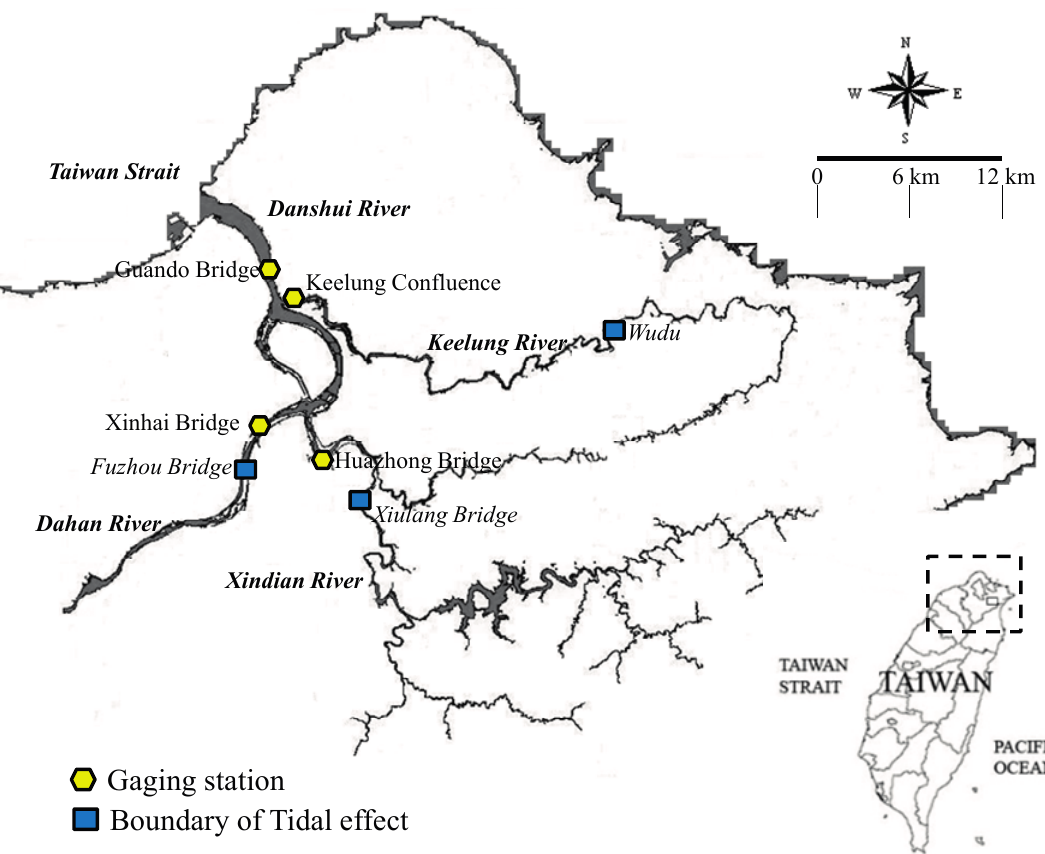
Figure 2. Location of the gauging station network in the Danshui River